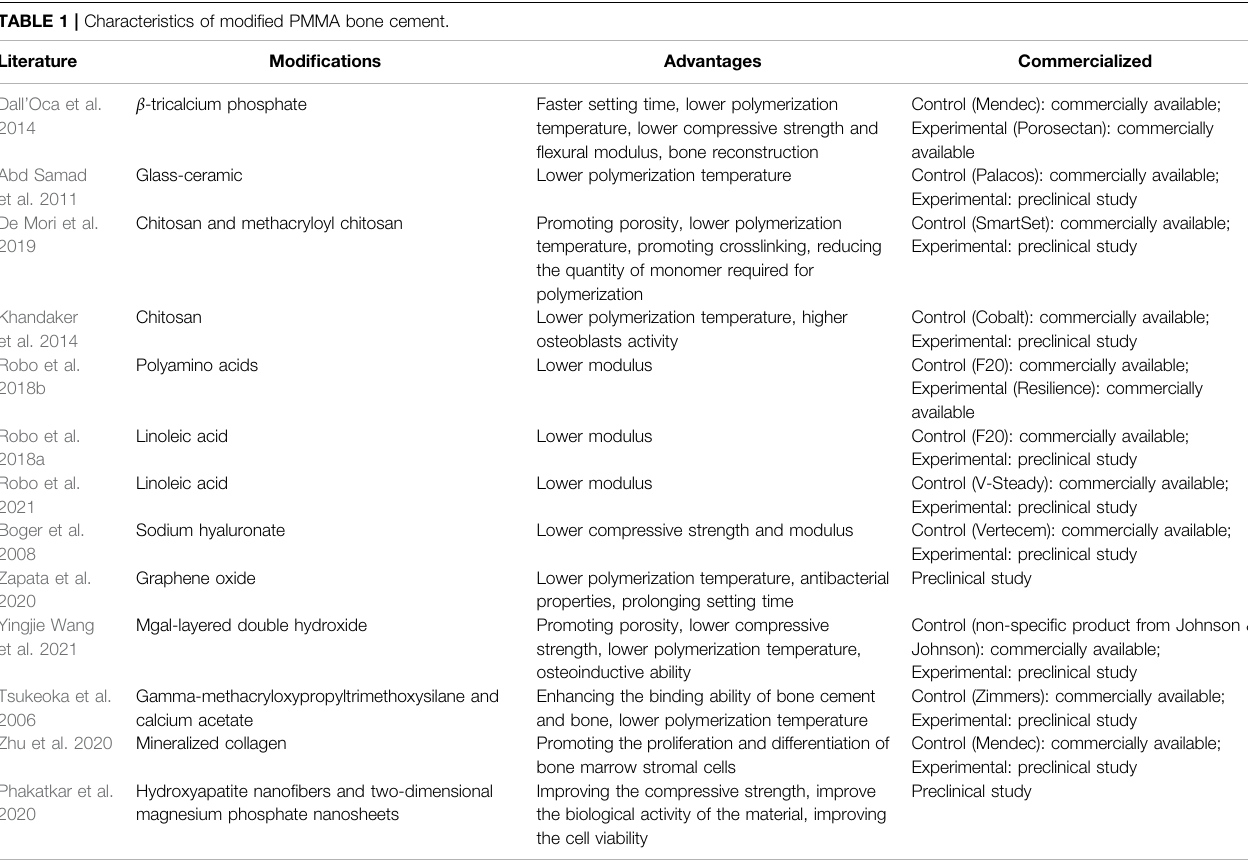
TABLE 1 | Characteristics of modi fi ed PMMA bone